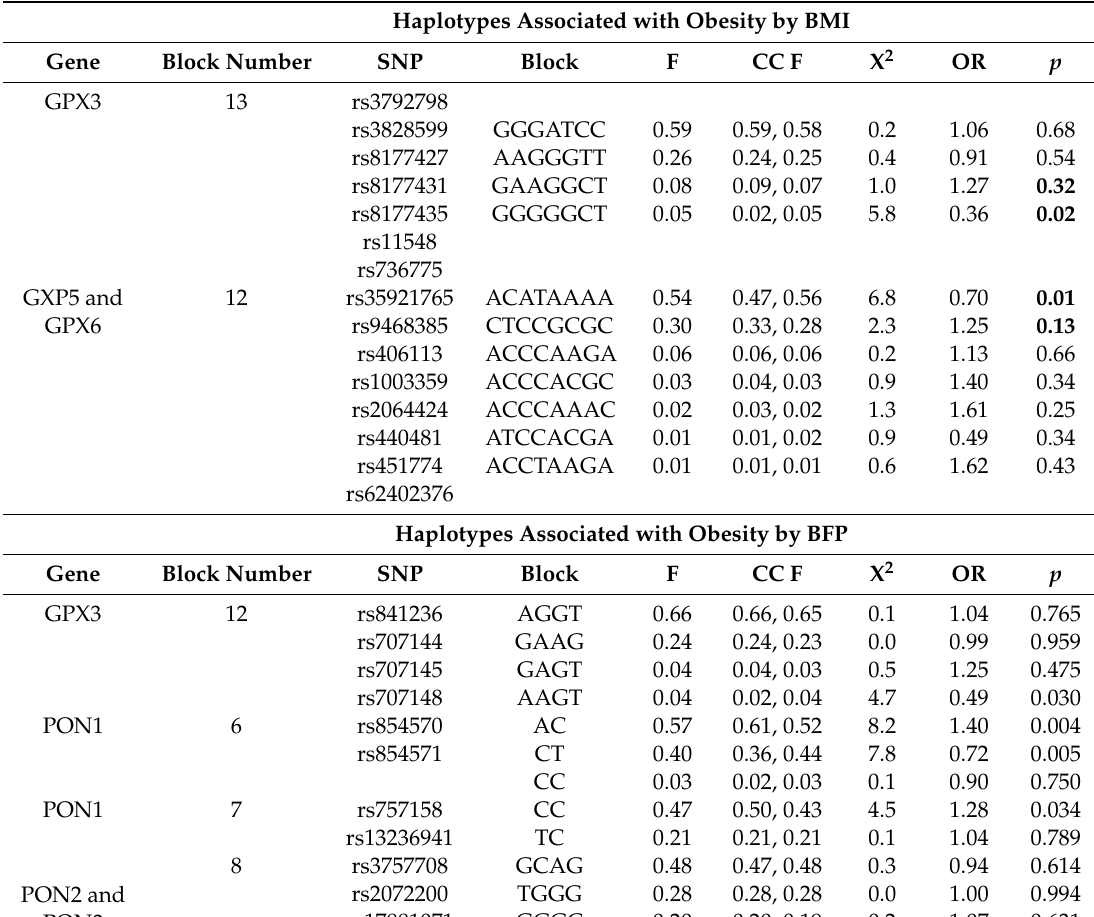
Table 2. Haplotypes associated with body mass index (BMI) and body fat percentage (BFP). Haplotypes Associated with Obesity by